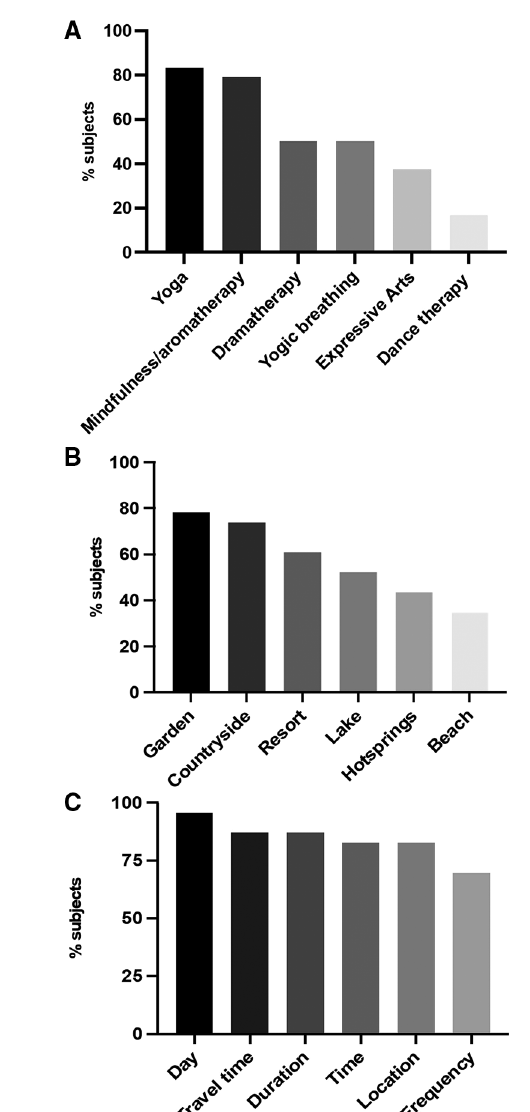
FIGURE 4 Intervention evaluation survey results are shown. Favorite modules are shown in panel A . Favorite venues are shown in panel B . Acceptability of logistics are shown in panel C .